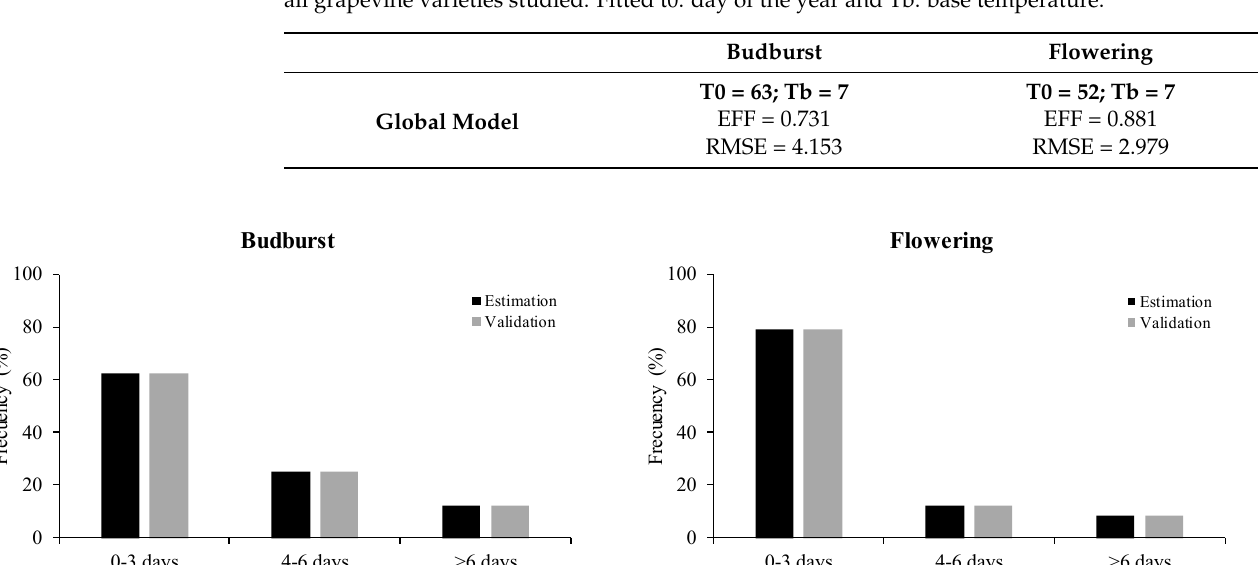
Table 4. Goodness-of-fit indicators of global GDD model for estimation process using the dataset for all grapevine varieties studied. Fitted t0: day of the year and Tb: base temperature.